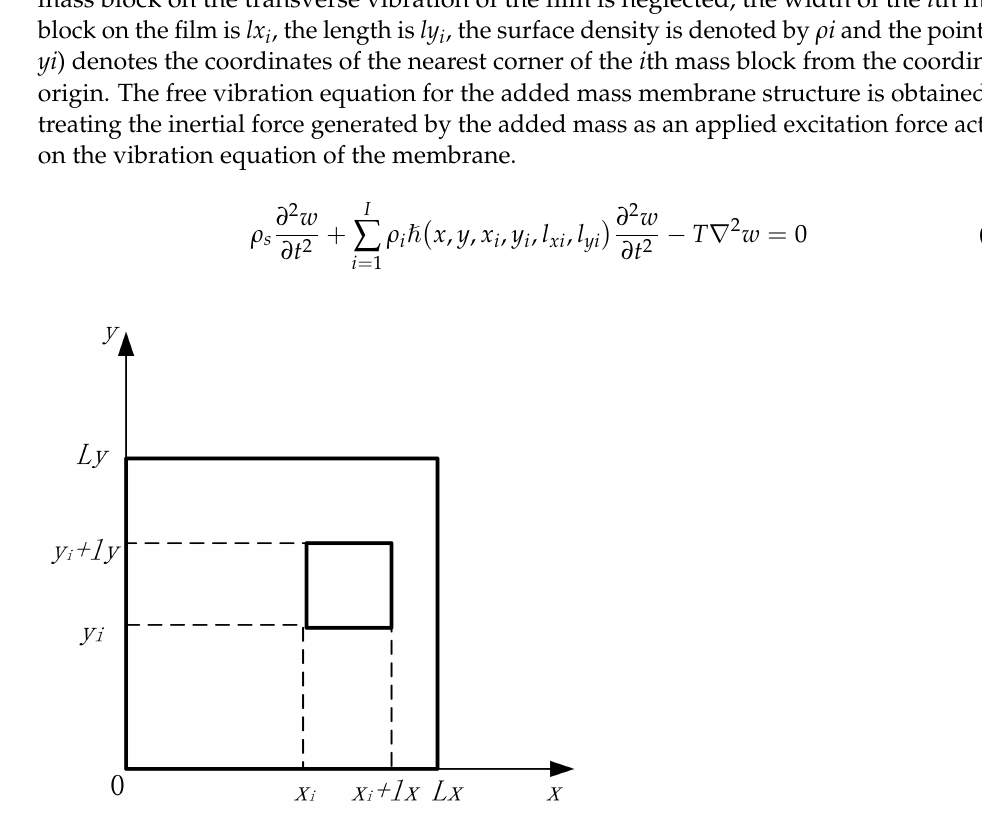
Figure 4. Additional distributed mass on the film surface at fixed